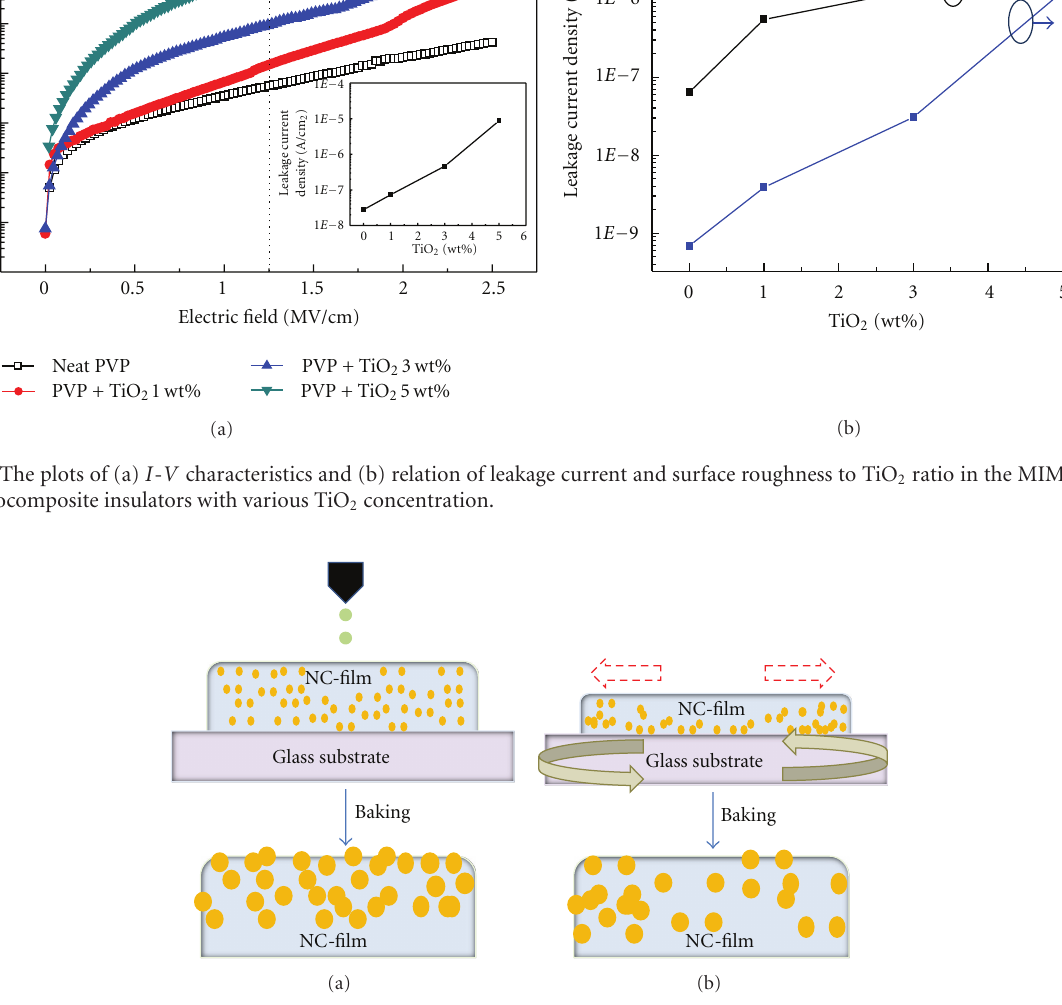
Figure 3: Film-forming mechanisms of NC-film: (a) inkjet printing (IJP); (b) spin coating (SPC).